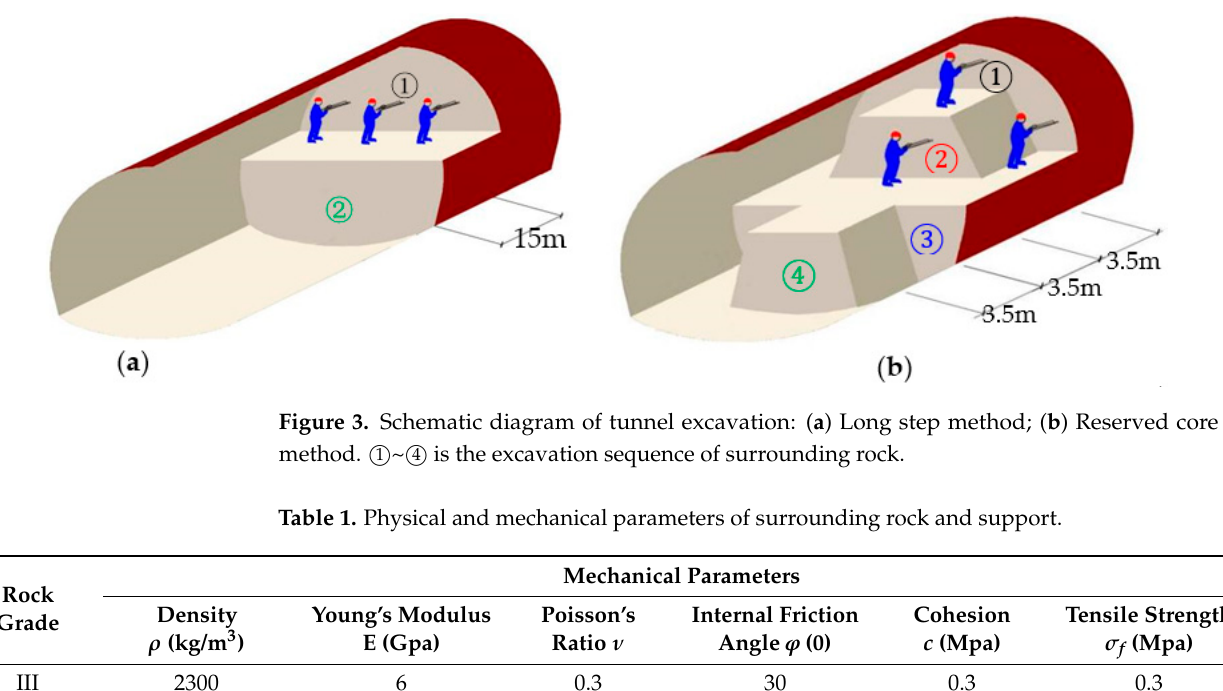
Table 1. Physical and mechanical parameters of surrounding rock and support.